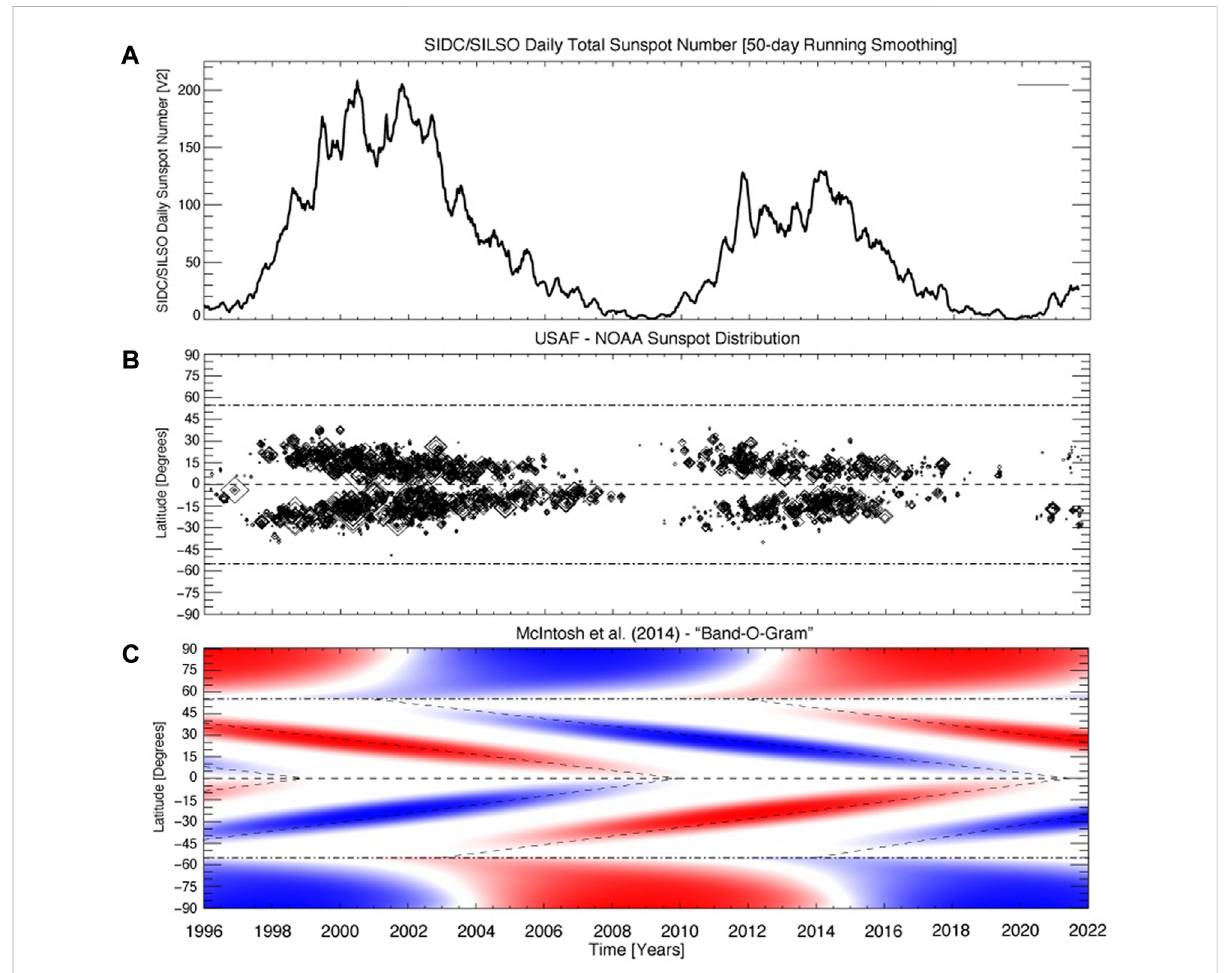
FIGURE 1 Sunspot evolution since 1996. Comparing and contrasting the evolution of the total sunspot number provided [panel (A) ], the spatio-temporal distribution of sunspots provided by the US Air Force and NOAA [panel (B) ], and a data-driven schematic of the Hale Cycle evolution constructed by M2014, the band-o-gram [panel (C)